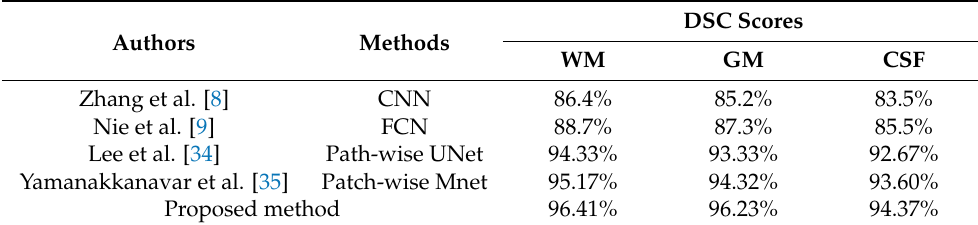
Table 3. Comparison of segmentation results of different